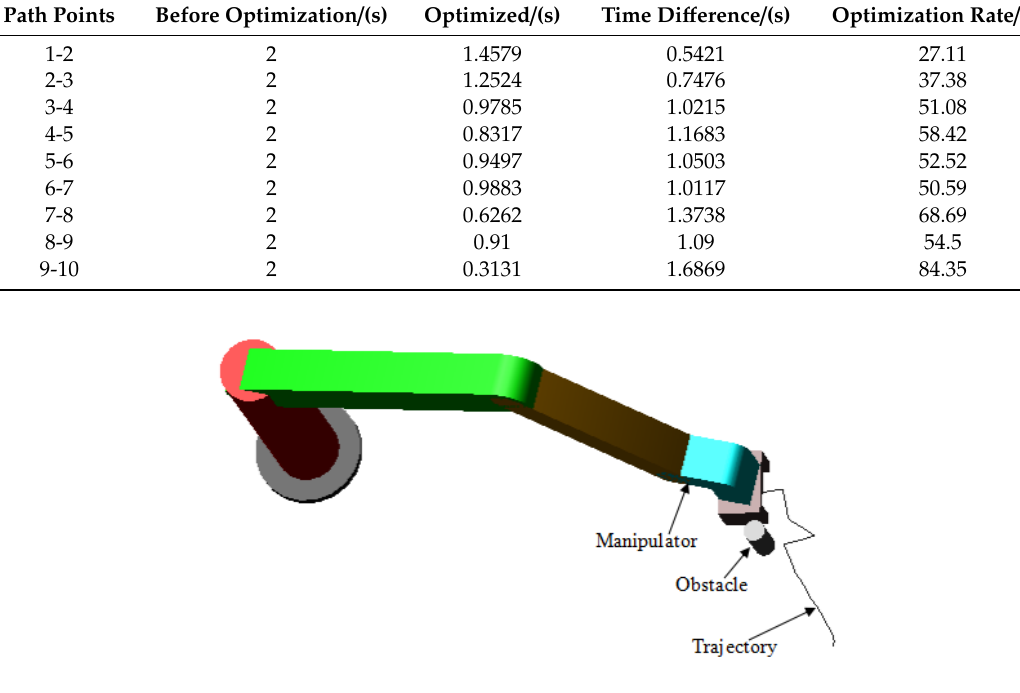
Figure 17. The displacement curve of the end-effector after the trajectory optimization.